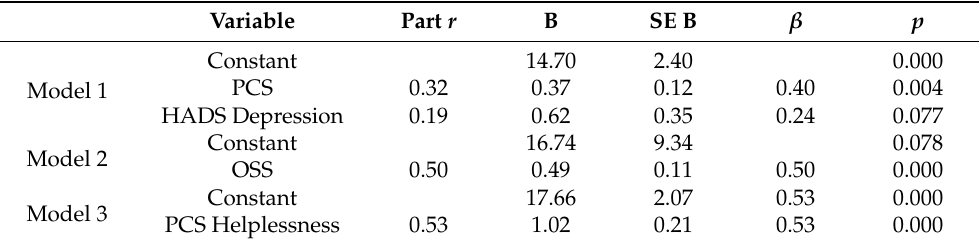
Table 3. Multiple regression analysis for the prediction of CSI scores from psychological and func- tional variables and the different dimensions of catastrophizing ( N = 64).